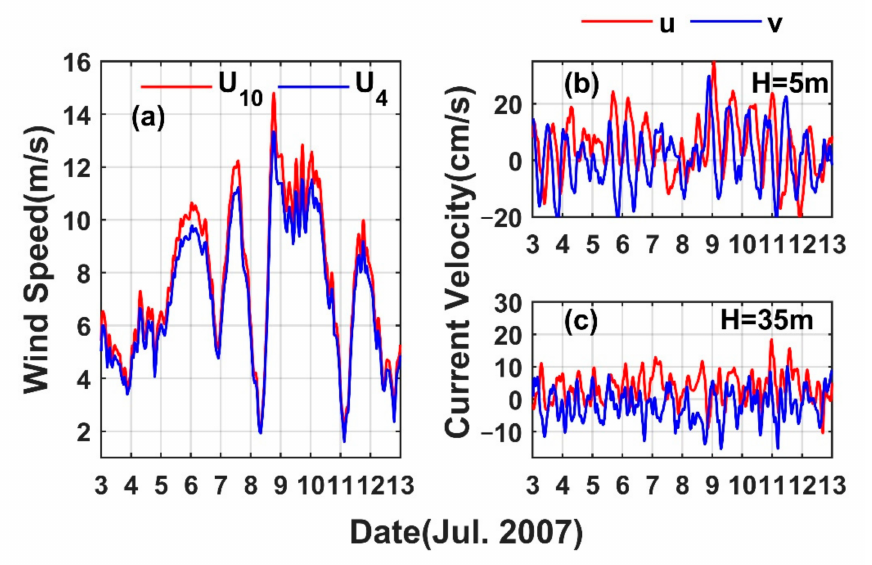
Figure 7. ( a ) The time series of the original wind speed U 4 and the standard wind speed U 10 , and the time series of total current velocity u and v for ( b ) 5 m, and ( c ) 35